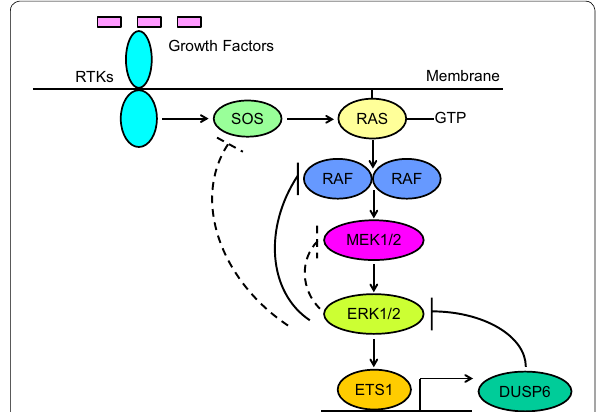
Fig. 1 Negative feedback regulates the RAS/MAPK pathway. Although MAPK signaling was previously considered linear, autoregu- latory negative feedback loops precisely control signaling output. MEK inhibitors reduce activity of ERK1 and ERK2 and then relieve the feedback inhibition of RAF, resulting in enhancement of RAF kinase activity. Likewise, ETS1-targeted therapy may activate ERK1 and ERK2 by inhibiting DUSP6, which is an ETS1 transcriptional